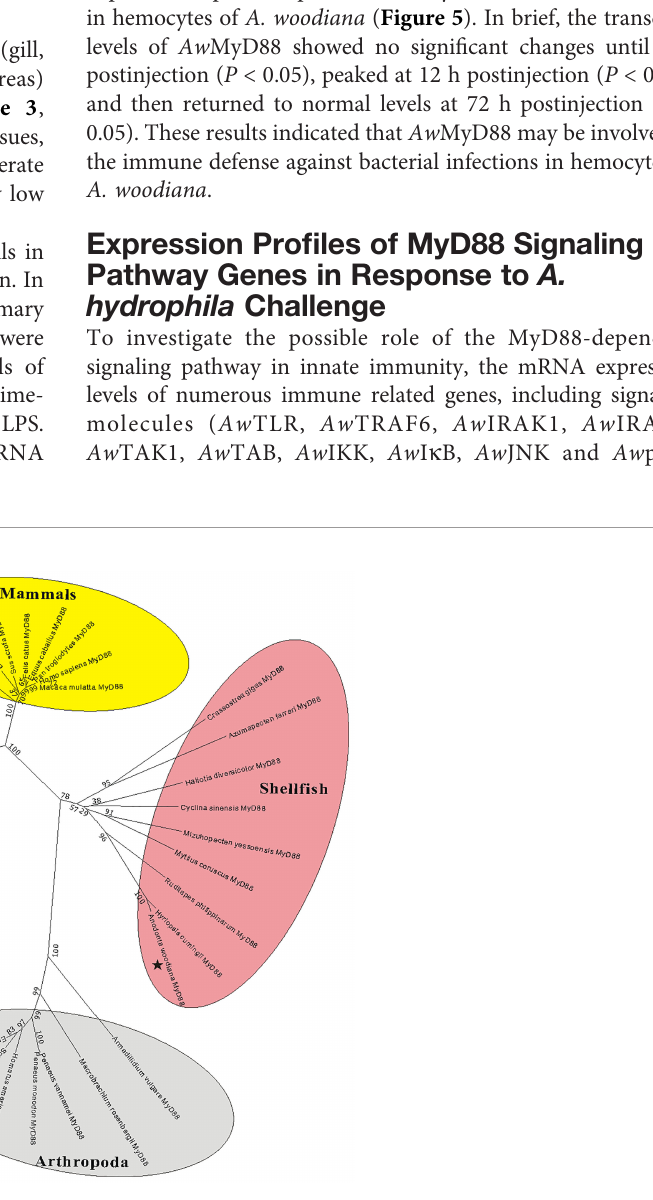
FIGURE 2 | Phylogenetic analysis of MyD88s by MEGA 5.0 software based on the neighbor-joining method. The numbers at the nodes represent bootstrap values for 1000 replications and the bar (0.1) indicates genetic distance. Aw MyD88 is labeled with a black